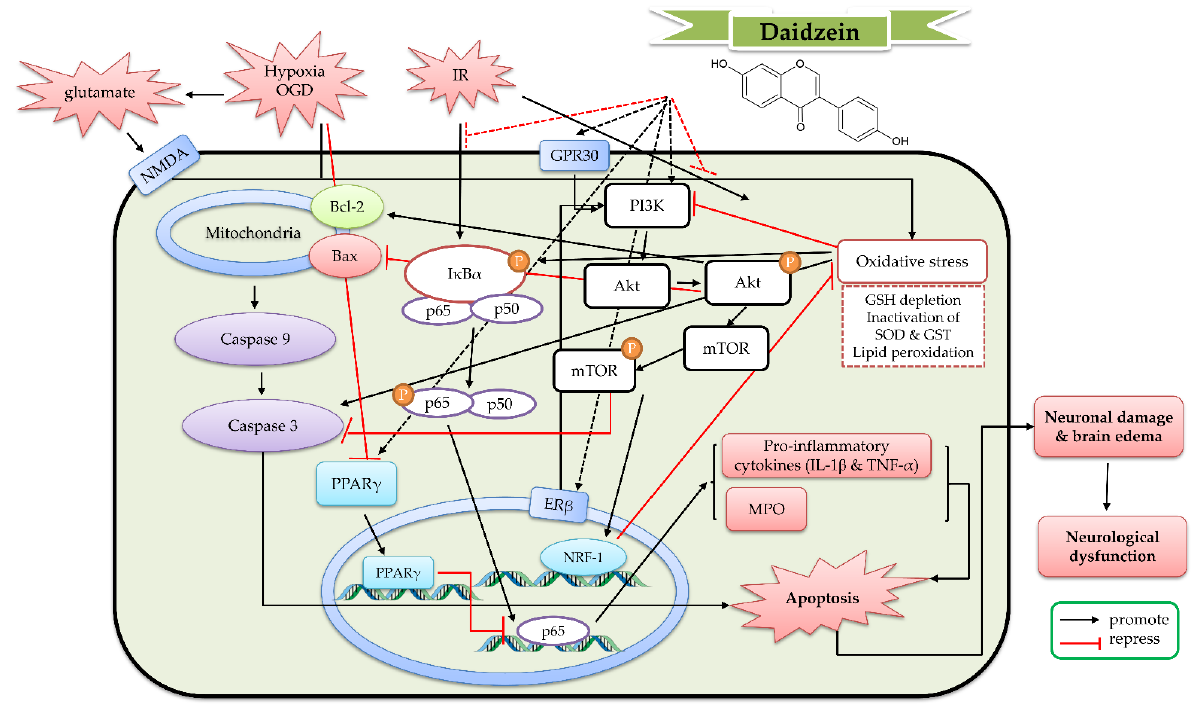
Figure 6. The protective effects of daidzein and daidzin against cerebral ischemia reperfusion (IR). Akt, protein kinase B; Bax, Bcl-2-associated X protein; Bcl-2, B-cell lymphoma 2, ER β , estrogen receptor β ; GPR30, G-protein-coupled receptor 30; GSH, glutathione; GST, glutathione sulfotransferase; I κ B, Inhibitor kappa B; IL-1 β , interleukin-1 β ; IR, ischemia reperfusion; MPO, myeloperoxidase; mTOR, OGD, oxygen-glucose deprivation; PI3K, phosphoinositide 3-kinase; PPAR γ , peroxisome